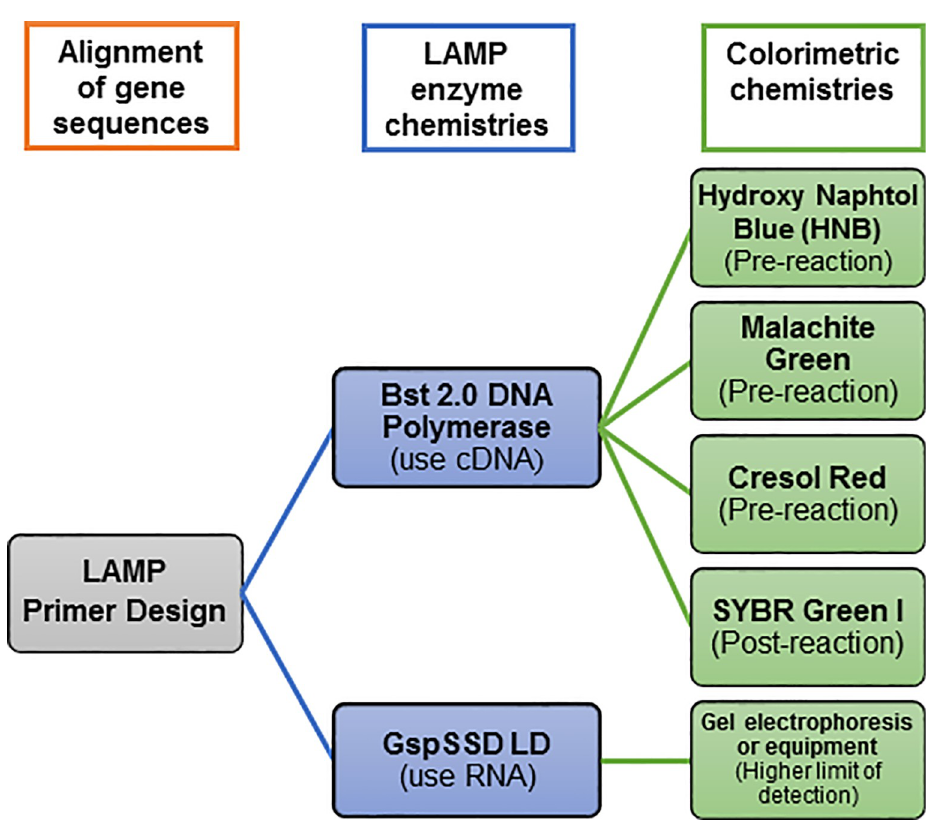
Fig 1. Flow chart showing the steps, methods, and chemistries used to explore Reverse Transcription Loop- Mediated Isothermal Amplification (RT-LAMP) targeting two genes of rose rosette virus (RRV) for detection of the